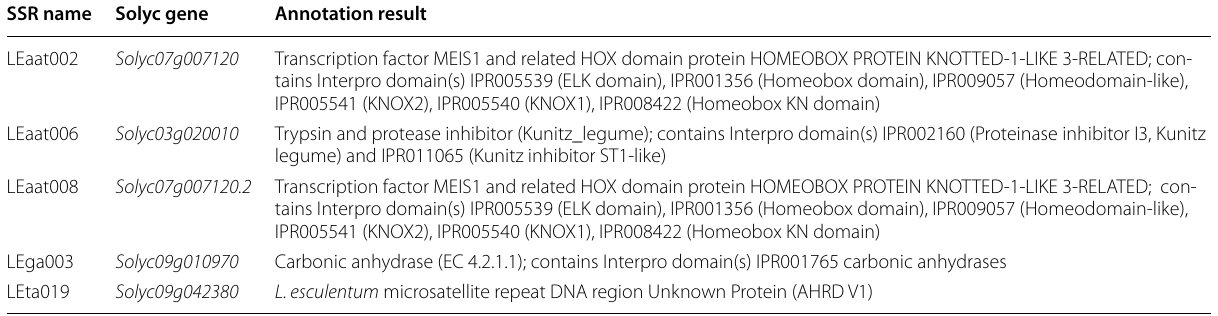
Table 4 BLAST corresponding Solyc ( Solanum lycopersicum ) gene sequences and annotation for SSR marker sequences SSR name Solyc